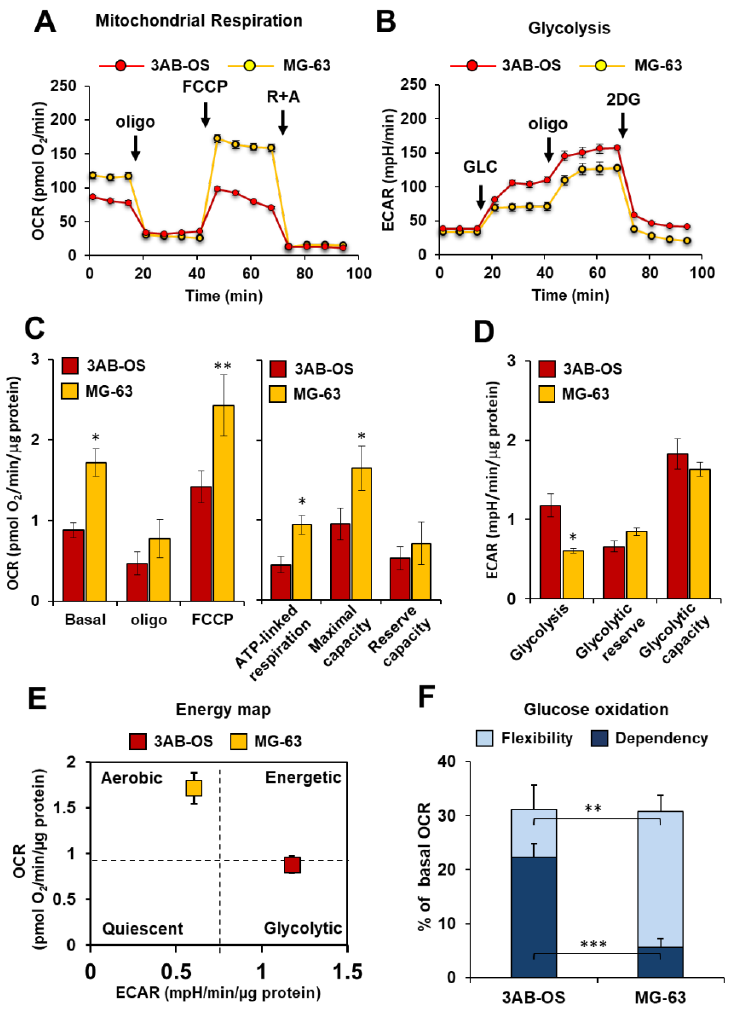
Figure 1. Comparative metabolic flux analysis of 3AB-OS and MG-63 cells, by using the Seahorse XFe96 Analyzer. ( A ) Representative profile of mitochondrial respiration stress test assay of 3AB-OS and MG-63 cells in basal condition, in presence of the ATP-synthase inhibitor oligomycin and after addition of the mitochondrial uncoupler FCCP. ( B ) Representative profile of glycolytic activity stress assay of MG-63 and 3AB-OS cells in presence of saturating amount of glucose (glycolysis), in presence of the glycolysis inhibitor 2-deoxyglucose (reserve), and after addition of the ATP-synthase inhibitor oligomycin (capacity). ( C ) Statistical analysis of the OCRs measured as in ( A ). Left panel: histograms showing basal OCR, OCR in the presence of oligomycin, OCR in the presence of FCCP; right panel: histograms showing ATP-linked respiration, maximal respiratory capacity and reserve capacity computed as described in Materials and Methods. The values are means ± SD of four independent experiments. * p < 0.05; ** p < 0.01. ( D ) Statistical analysis of the ECARs measured as in ( B ). The histograms show basal glycolysis, glycolytic reserve and glycolytic capacity as described in Materials and Methods. The values are means ± SD of four independent experiments. * p < 0.05. ( E ) Energy map was obtained plotting basal OCR versus basal ECAR of 3AB-OS and MG-63 cells. ( F ) Evaluation of mitochondrial glucose usage in 3AB-OS and MG-63 cells, expressed as percentage of basal OCR. Glucose dependency indicates cell reliance on the glucose oxidation pathway to maintain basal respiration. Metabolic flexibility to glucose is the ability of cells to compensate for the inhibition of the glucose oxidation pathway by oxidation of alternative substrates to fuel mitochondrial OxPhos. The values are means ± SD of three independent experiments. ** p < 0.01; *** p < 0.001. Abbreviations: oligo , oligomycin; FCCP , carbonyl cyanide 4-(trifluoromethoxy)phenylhydrazone; R , rotenone; A , antimycin A; GLC , glucose; 2DG , 2-deoxy-D-glucose; OCR , oxygen consumption rate; ECAR , extracellular acidification